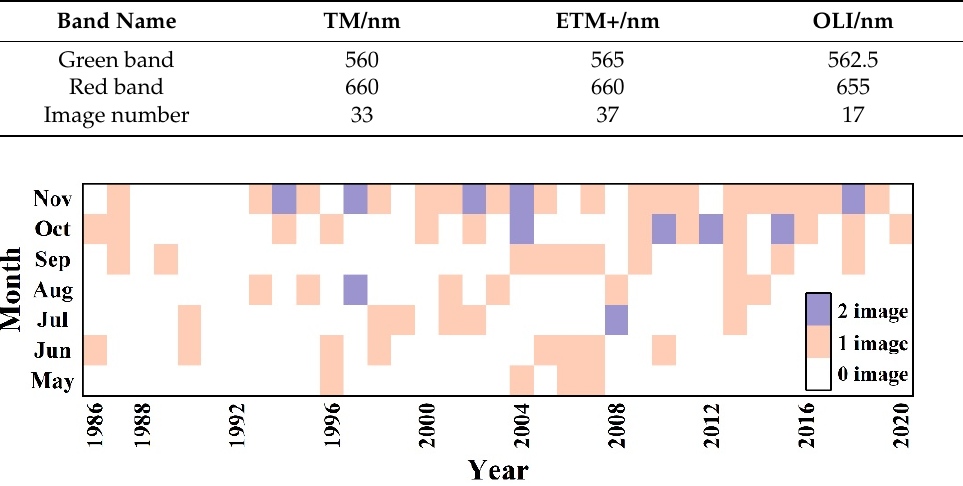
Figure 2. Cloud-free Landsat images of Lake Qinghai used herein during the periods from 1986 to 2020.